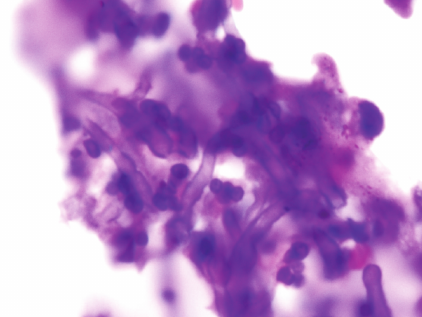
Figure 6: Periodic acid Schiff stained HPE picture showing 45 degrees branching of fungal hyphae characteristic of Aspergillus